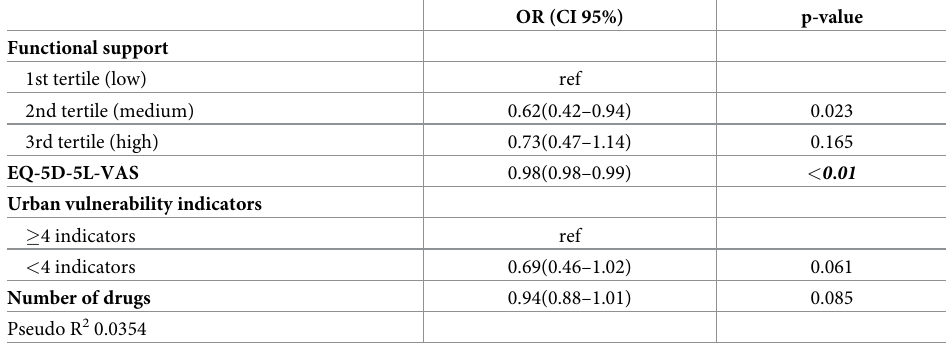
Table 4. Factors associated with nonadherence to treatment in patients with multimorbidity and polypharmacy. Final model with those variables that were significantly associated in Table